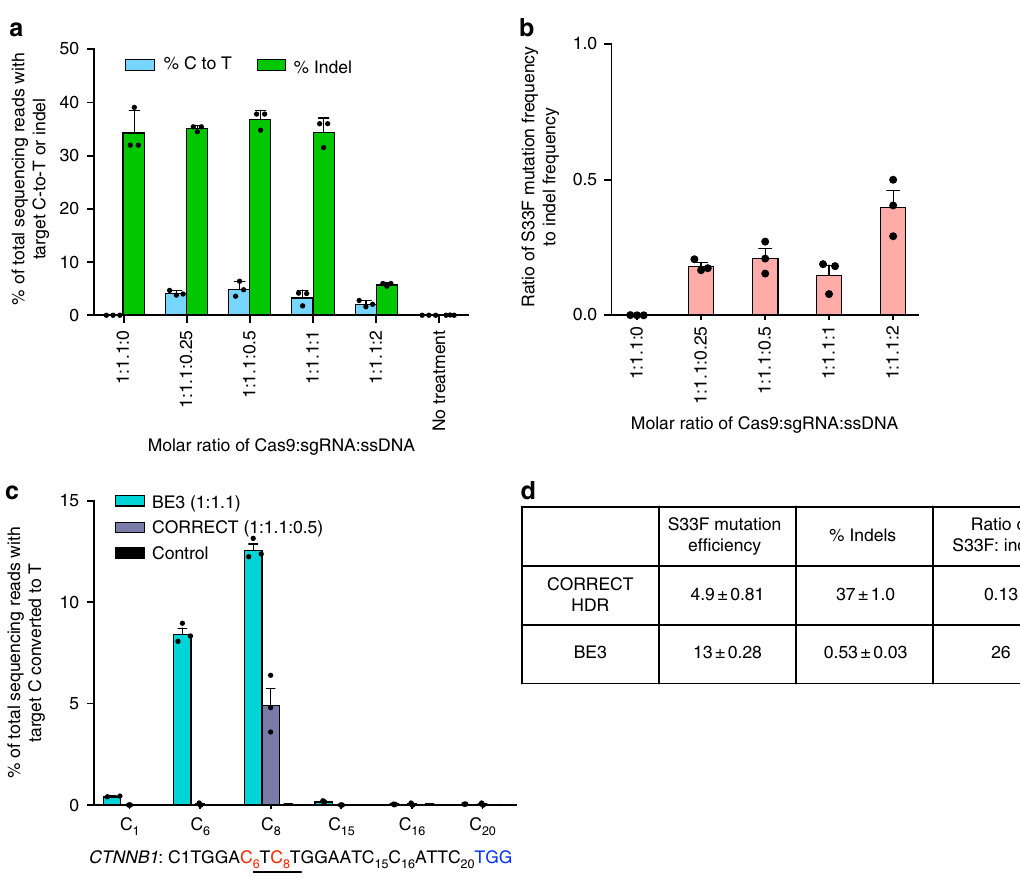
Fig. 3 Comparison of ef fi ciency and product selectivity of HDR vs. base editing following RNP delivery. RNP delivery into HEK293T cells of 200 nM Cas9 or 200 nM BE3 pre-complexed with the S33-targeting sgRNA or an unrelated sgRNA and delivered in a cationic liposome. a Frequency of S33F mutation (blue) and indels (green) from treatment with CORRECT HDR agents (Cas9, sgRNA, and ssDNA donor template) in the ratios shown. b Product selectivity ratio, de fi ned as the ratio of S33F modi fi cation to indel modi fi cation, resulting from treatment with the CORRECT HDR agents used in a . c Comparison of target C to T conversion ef fi ciency following RNP delivery of BE3 (blue) or CORRECT HDR (purple) and the S33-targeting sgRNA. The control corresponds to cells treated with BE3 protein and unrelated sgRNA. d Product selectivity of base editing and CORRECT HDR. Values and error bars re fl ect mean ± S.E.M. of three independent biological replicates performed on different HDR with a donor DNA template that both installs the desired mutation and that alters the PAM sequence to prevent re-cutting of the desired DNA product. Lipid-mediated plasmid transfection of Cas9:sgRNA constructs and an optimized amount of ssDNA donor template into HEK293T cells resulted in levels of precise installation of β -catenin S33F (5.4 ± 0.6%) and indels (49 ± 7%) consistent with previous reports 40 (Fig. 1c). Since plasmid transfection of BE3:sgRNA constructs resulted in 31 ± 0.9% conversion of β -catenin Ser 33 to Phe and 2.0 ± 0.3% indels (Fig. 1d), the product selectivity ratio (desired S33F mutation: undesired indel ratio) was 0.11 for CORRECT HDR and 16 for base editing, a 140-fold difference. We recently demonstrated delivery of Cas9 nuclease ribonu- cleoprotein (RNP) complexes to the inner ear to mediate spatially localized genome editing in vivo with enhanced DNA speci fi city relative to plasmid transfection 11,41,42 . In light of these advan- tages, we also compared RNP delivery of base editors with RNP delivery of HDR agents. We optimized RNP delivery-mediated CORRECT HDR by treating cells with different stoichiometries of Cas9 protein, S33-targeting sgRNA, and a donor ssDNA template. Optimized cationic lipid-mediated delivery of Cas9, guide RNA, and donor DNA template resulted in an average